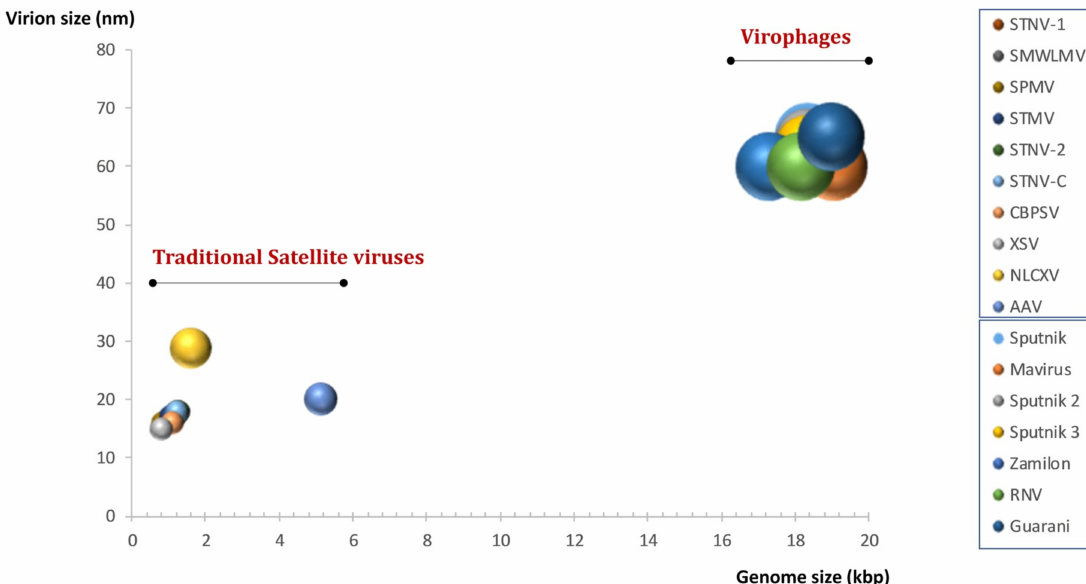
Figure 6. The parasites of the giants are giants. Plot comparing the virion and genome sizes for known virophages and some traditional satellite viruses. The ball sizes are proportional to the capsid